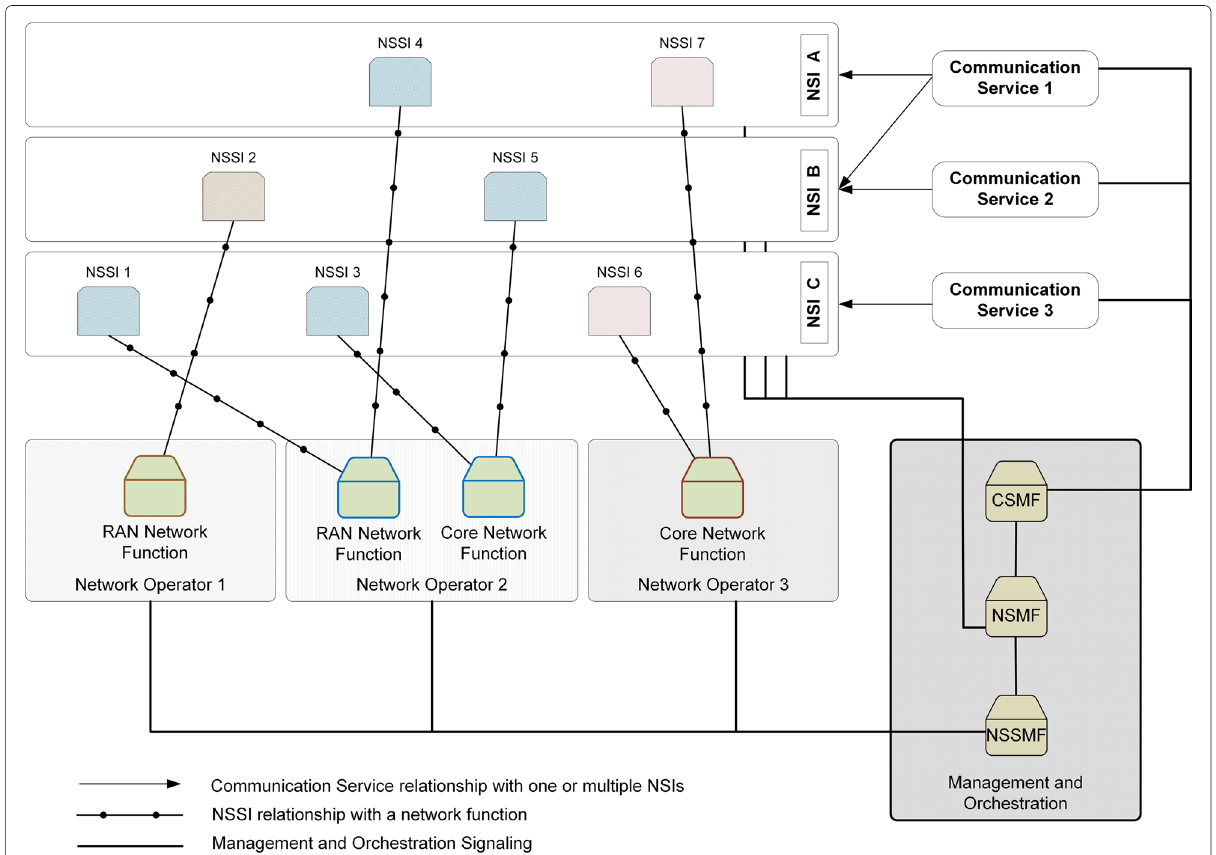
Fig. 11 Rel. 15 network slicing architecture. The CSMF is responsible for translating communication service-related requirement to network slice-related requirements and communicates with the NSMF. The NSMF is responsible for management and orchestration of NSI and communicates with the NSSMF. The NSSMF is responsible for management and orchestration of